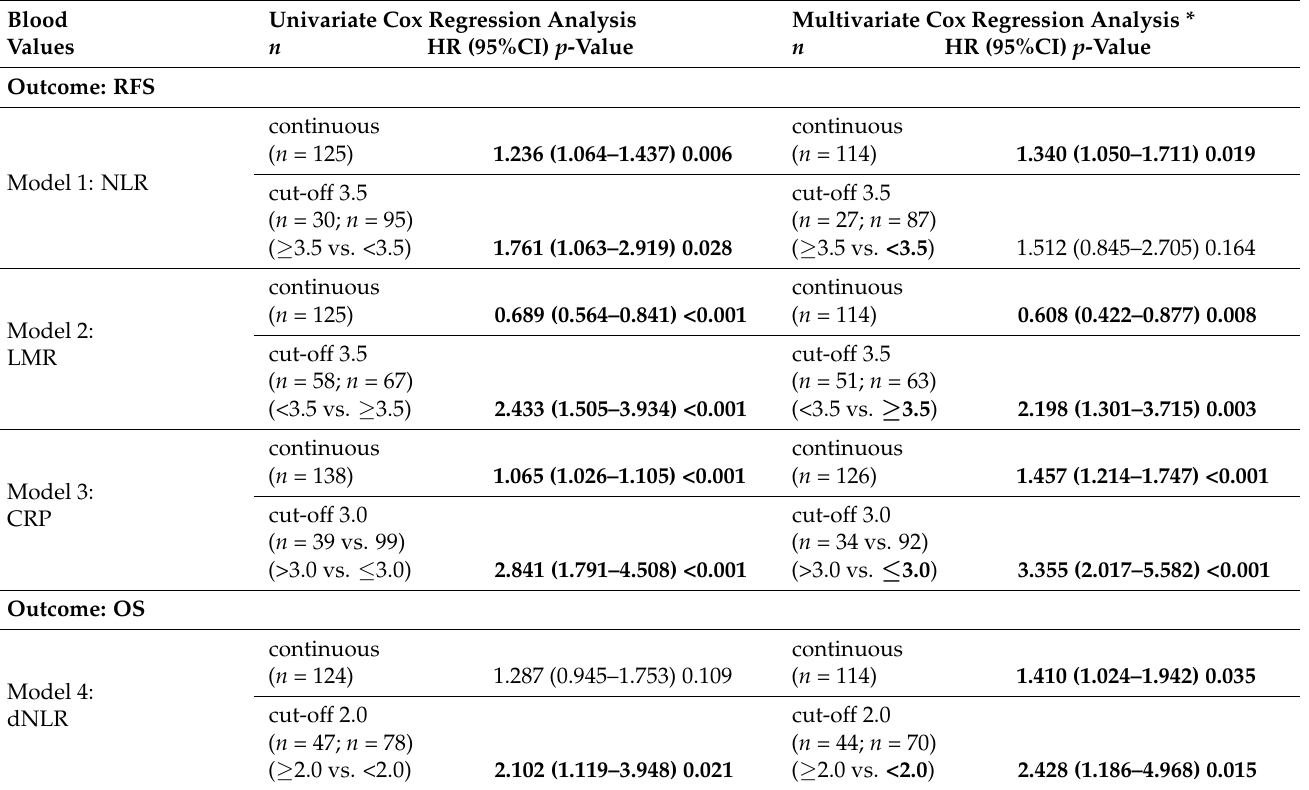
Table 4. Significance of neutrophil-to-lymphocyte ratio (NLR), lymphocyte-to-monocyte ratio (LMR) and C-reactive protein (CRP) for recurrence-free survival (RFS) and derived NLR (dNLR) for over- all survival (OS) as continuous and dichotomized variables in univariate and multivariate Cox regression